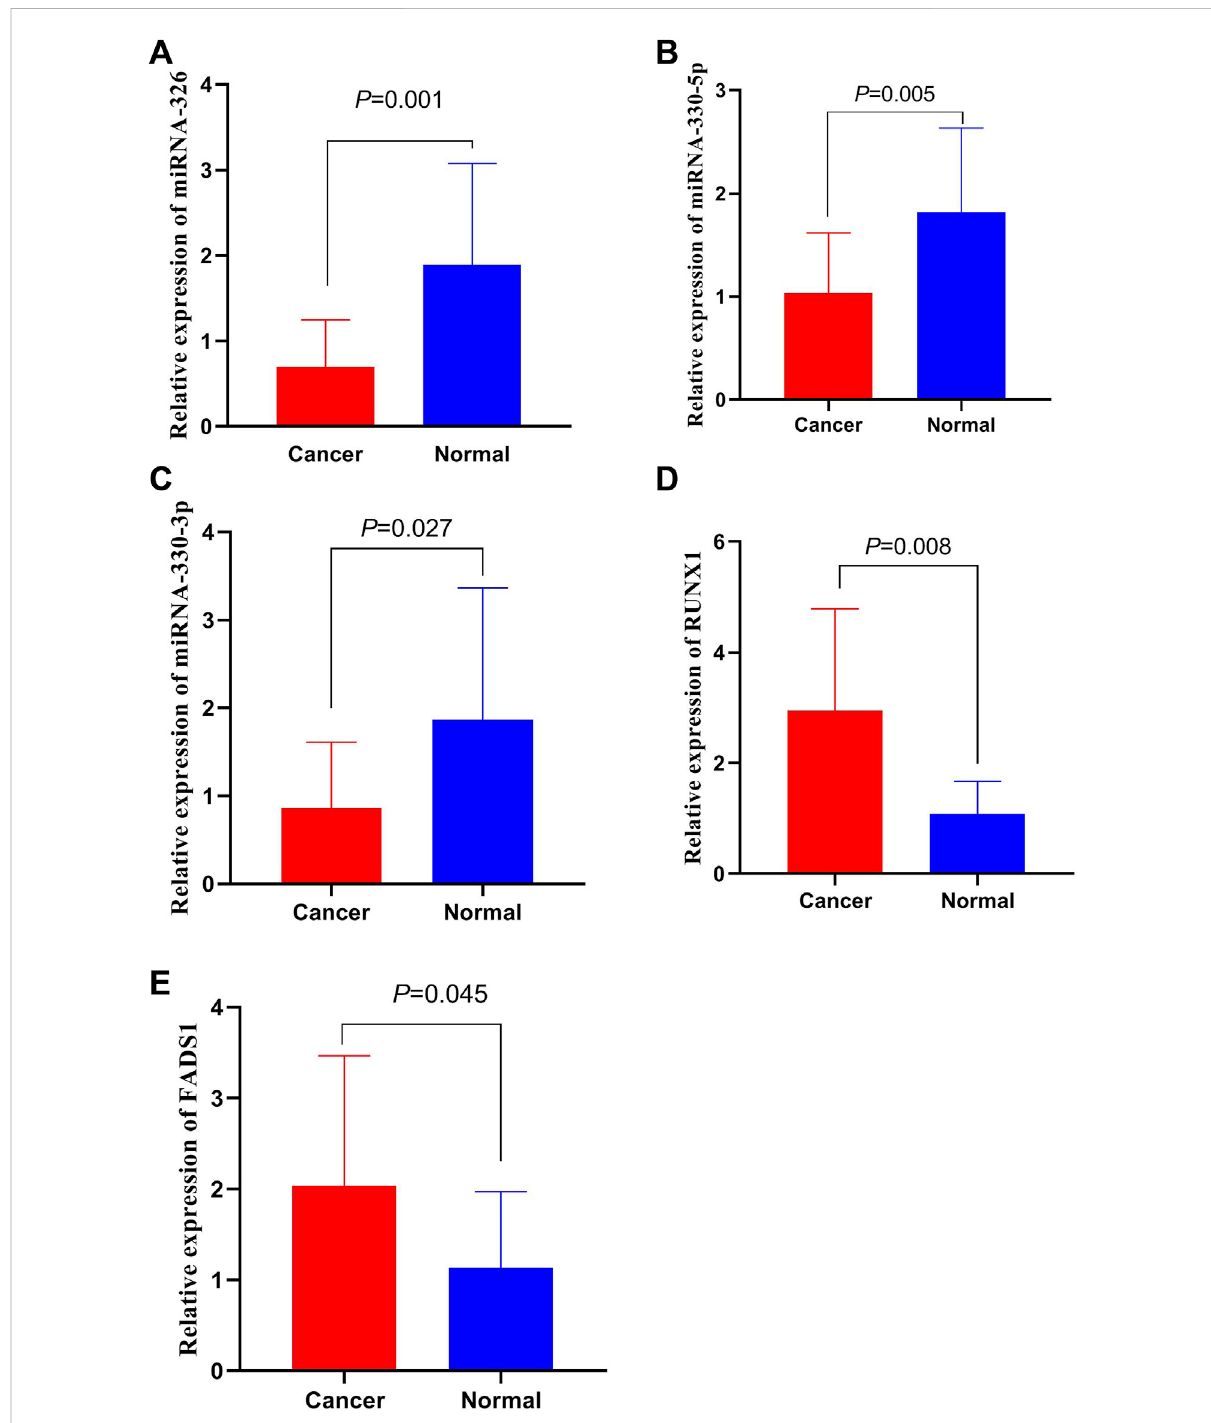
FIGURE 6 TheexpressionofmiRNAsandmRNAsinCRCtissues. (A) TheexpressionsofmiR-326inCRCtissues. (B) TheexpressionsofmiR-330-5pinCRC tissues. (C) TheexpressionsofmiR-330-3pinCRCtissues. (D) Theexpressionsof RUNX1 inCRCtissues. (E) Theexpressionsof FADS1